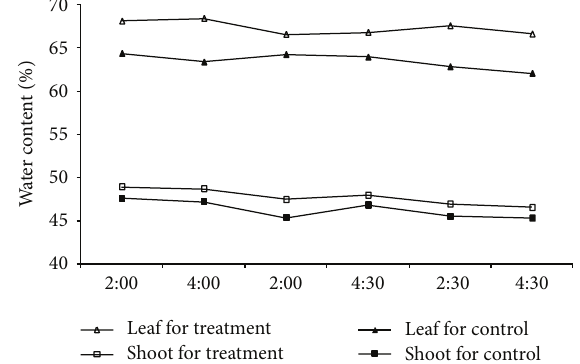
Figure 4: Water contents of leaves and shoots of T. ramosissima for control and treatment groups during the same time as mentioned in Figure 3. No error bars are presented for each data point, because the standard error of each data point is significantly smaller than the unit length of water